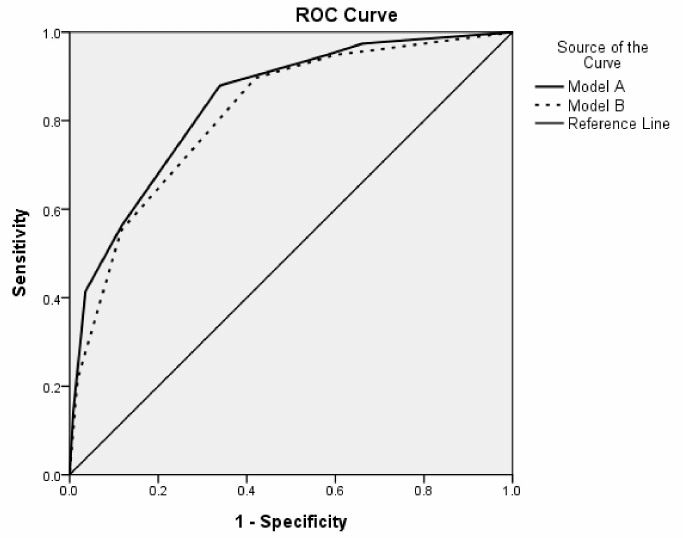
Figure 3. The ROC curve of two proposed scoring models. In model A, AUROC was 0.84 (95% CI: 0.79–0.89) and the p value was 0.000; in model B AUROC was 0.82 (95% CI: 0.76–0.87) and the p value was 0.000; the cut-off value of the score in model A was 3 points and 2 points in model